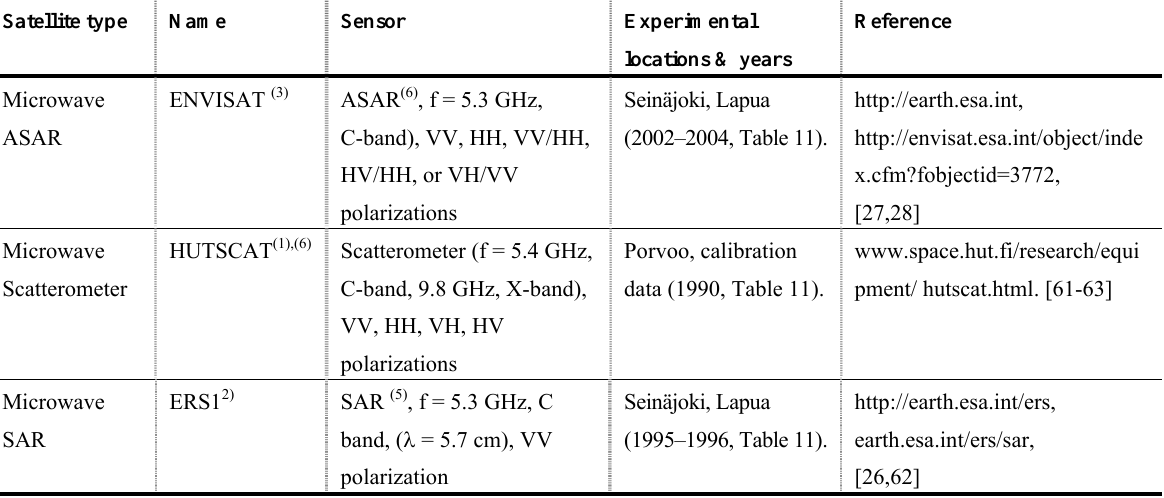
Table 10. SAR and optical satellite systems used in remote sensing